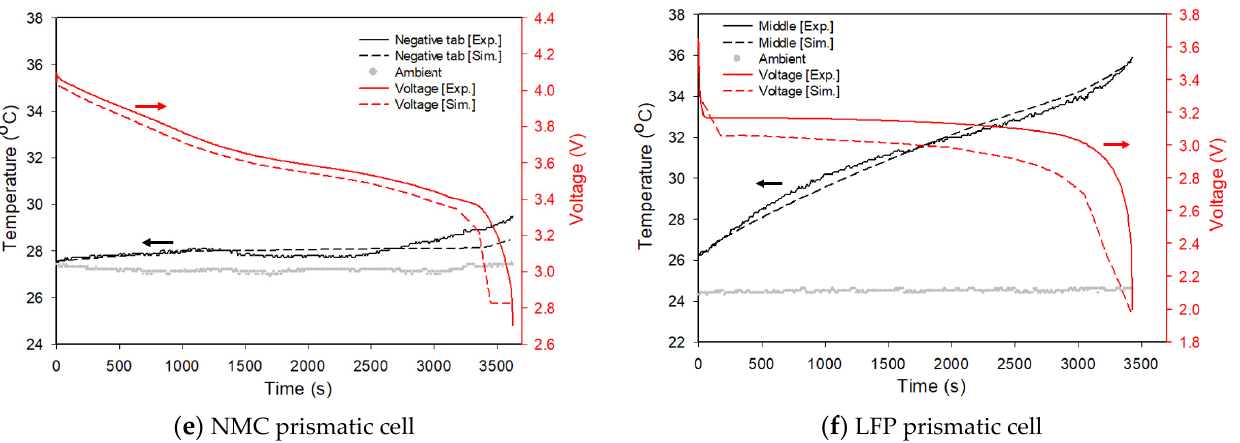
Figure 11. The validation of simulation with experimental results of the battery surface temperature and cell voltage characteristics: ( a ) NMC cylindrical, ( b ) LFP cylindrical, ( c ) NMC pouch, ( d ) LFP pouch, ( e ) NMC prismatic, and ( f ) LFP prismatic.